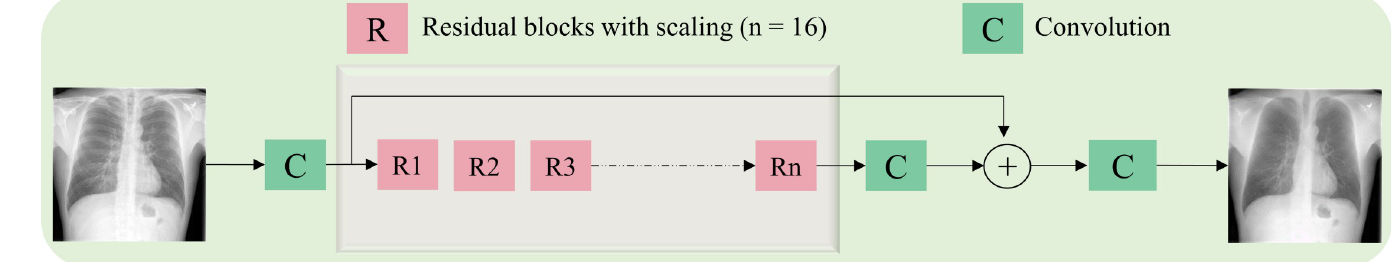
Fig 3. The architecture of the ResNet-BS model. The input is a grayscale CXR image. The block R denotes the modified residual block. The proposed model has 16 residual blocks, each having two convolutional layers with 3 × 3 filters and 128 feature maps. The deepest convolutional layer with sigmoidal activation predicts the grayscale bone-suppressed